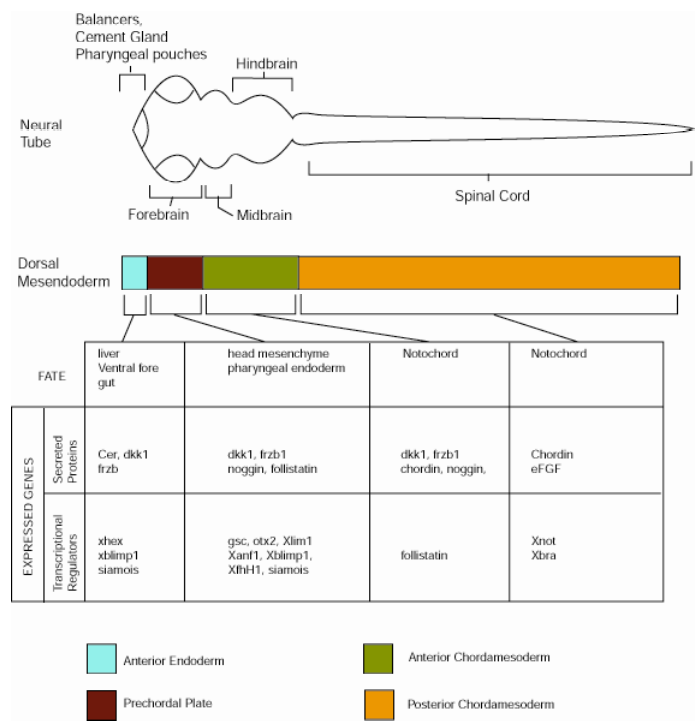
FIGURE 2. Expression patterns of secreted ligands and transcriptional regulators in the dorsal mesendoderm that specify anterior-posterior development in the nervous system of